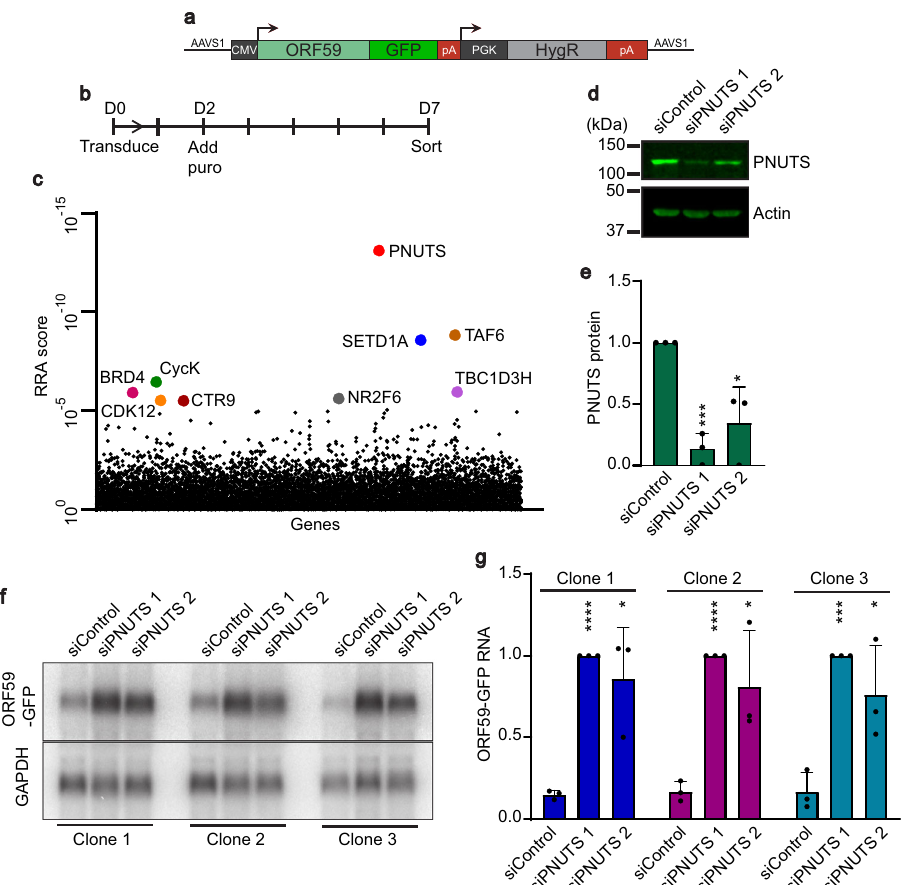
Fig. 1 | A CRISPR screen identi fi es PNUTS as a potential suppressor of KSHV ORF59 expression. a Schematic of ORF59-GFP reporter with fl anking AAVS1 homology arms. Dark gray boxes are CMV and PGK promoter regions. PolyA sig- nals,pA(red). b TimingofCRISPRknockoutscreenfromlentivirustransductionto sorting, seven days overall with fi ve days of puromycin selection. c Gene enrich- ment plot from three biological replicates of CRISPR knockout screen; genes and non-targeting sgRNAs plotted alphabetically on X -axis. Y -axis is the robust rank aggregation (RRA) scores for each gene. Top nine genes with false discovery rate (FDR) scores <2% denoted with colored dots and labels. d Western blot of total proteinfromtheHCT116reporterlinetreatedsiRNAsasindicated. e Quanti fi cation of PNUTS protein levels after siRNA-mediated knockdown, as in ( d ). Values were fi rst normalized to beta-actin then quanti fi ed relative to siControl. Error bars are